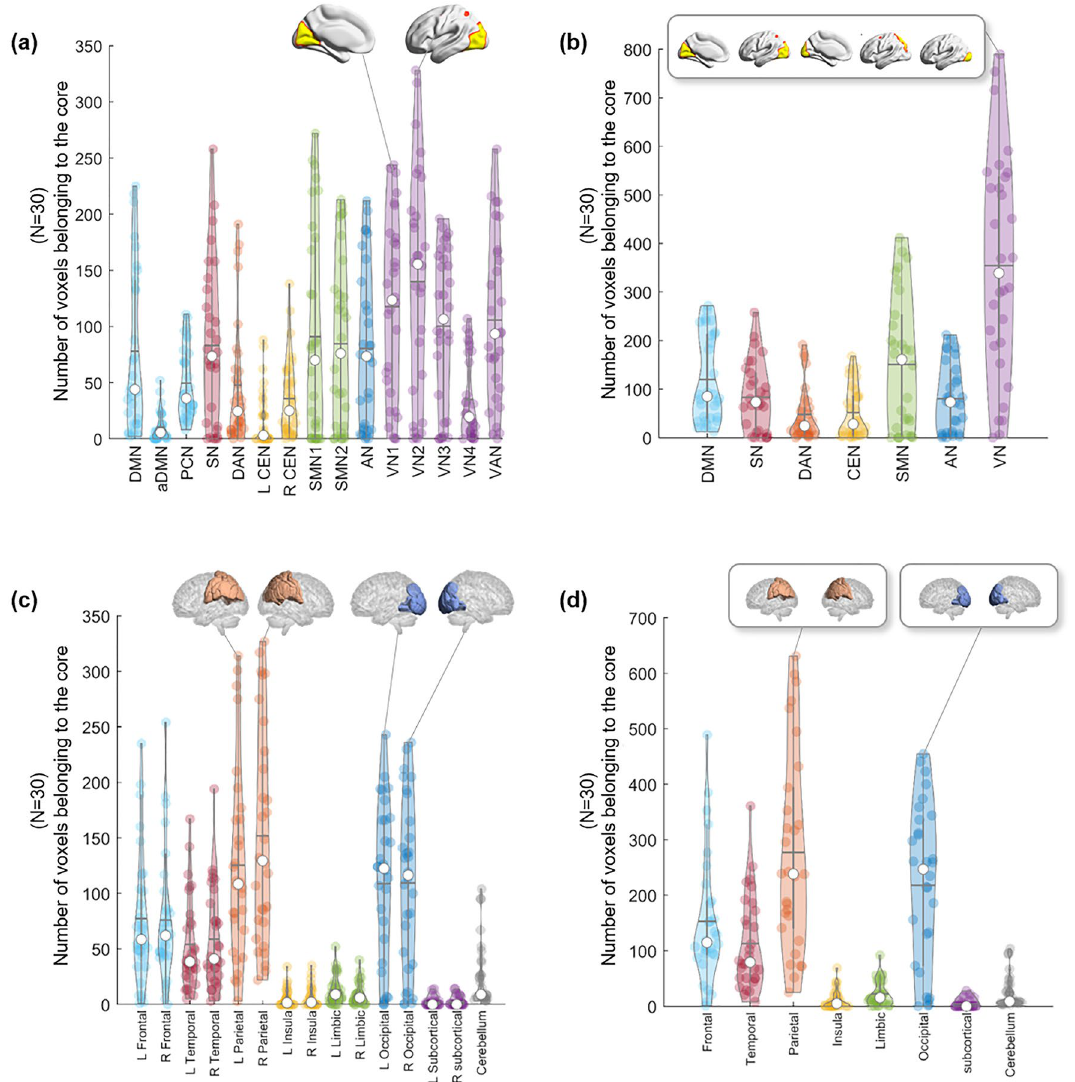
max -core voxels belonged. ICs were represented as 15 ( a ) or as the seven categorized ( b ). Five visual networks (VN1/2/3/4, VAN) into one visual network (VN), etc. Since some of the voxels belong to multiple ICs, categorized VN had slightly fewer voxels than the sum of the number of voxels of constituents (V1/2/3/4, VAN). ( a ) According to the fifteen functional labels, visual subnetworks, VN1, VN2, and VN3, and the visual attention network (VAN) were leading in the number of voxels among k max -core voxels, followed by sensorimotor networks (SMN 1, 2) and the salience network (SN). ( b ) Once categorized, the propensity of VN among the seven was outstanding. ( c ) Anatomical labels for both lobes and cerebellum showed prominence of occipital and parietal lobes among the fifteen, and ( d ) once categorized to eight, parietal and occipital lobes were